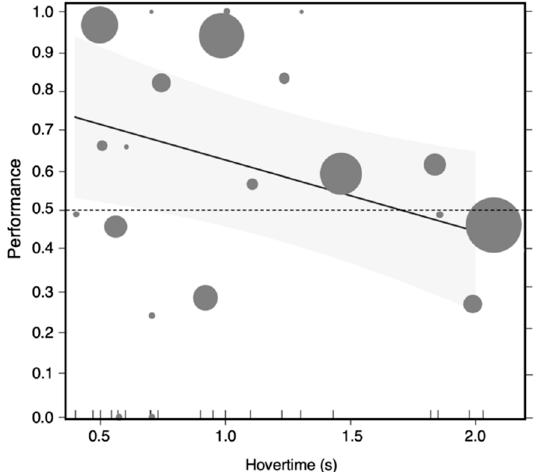
Figure 4. In-flight decision performance was influenced by decision time. Observer bees made significantly more correct in-flight decisions (choosing the reward-predicting live demonstrator or rejecting the punishment-predicting live demonstrator) than chance level (50%). The proportion of correct decisions decreased over hovering time. The figure shows the predicted levels of performance (proportion of correct decisions) and its 95% confidence band for the sample values of hovering time before decision. Each circle represents in-flight decision performances and mean hovering times before decision for individual bees. The size of the circle indicates the total number of decisions for individual bees. The horizontal dashed line indicates the chance level (50%).